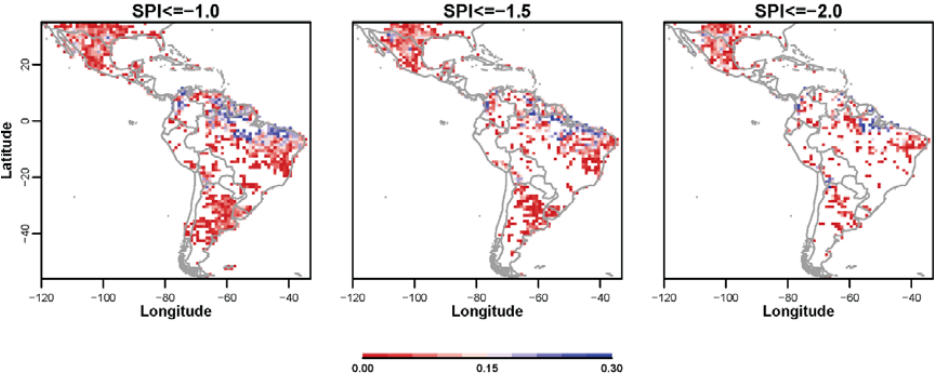
Figure 7. Brier Skill Score (BSS) of the ECMWF S4 SPI ‐ 6 forecast for different probabilities of SPI occurrence, at a lead time of 3 months for the hindcast period 1981–2010. Values are indicated in the color bar; land grid points colored in white indicate that the forecasting system is no more skillful than the climatology.